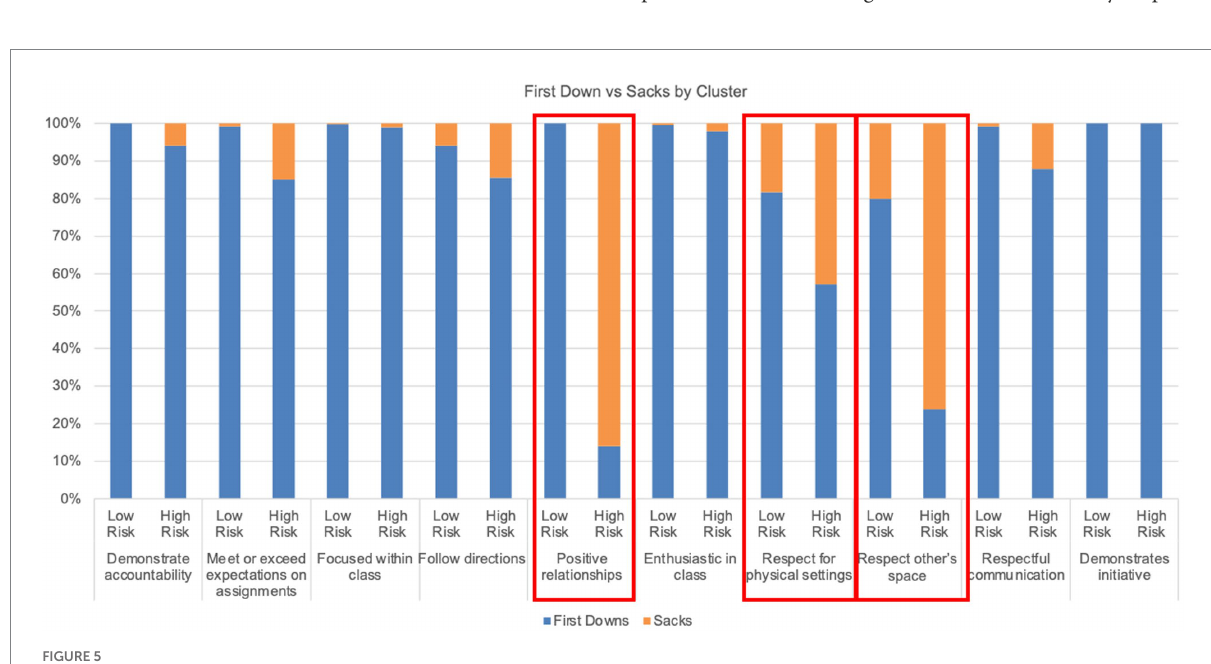
FIGURE 5 Core value comparison between C LR and C HR labeled